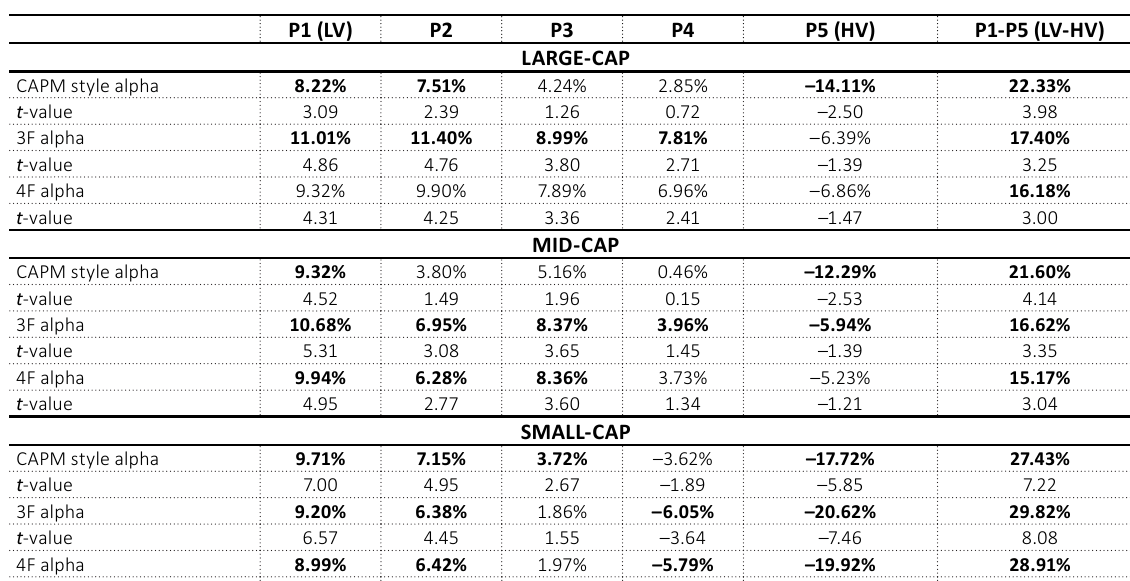
Table 16. CAPM styl e alpha, three-factor alpha and four-factor alpha of volatility ranked portfolios within various size buckets